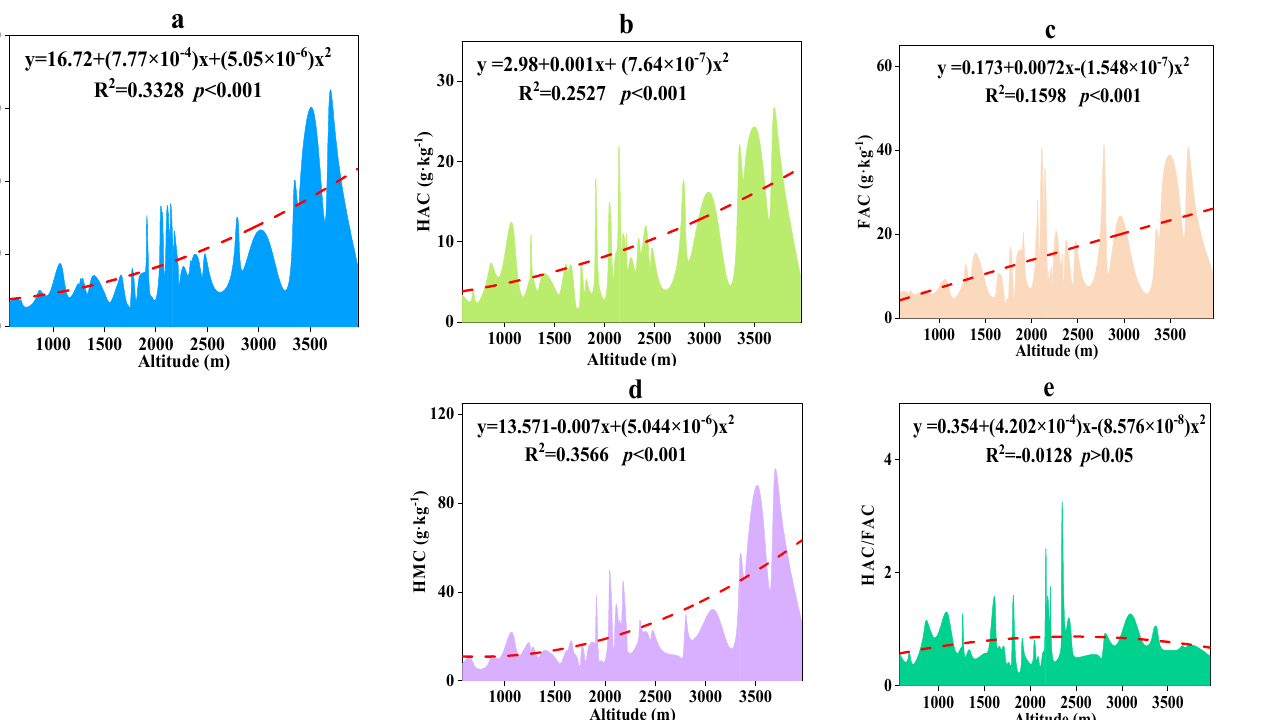
Figure 6. Relationship between altitude and the composition of soil organic matter (figure ( a ): SOC; figure ( b ): HAC; figure ( c ): FAC; figure ( d ): HMC; figure ( e ): HAC/FAC). FAC, fulvic acid carbon; HAC/FAC, humic acid carbon/fulvic acid carbon; HAC, humic acid carbon; HMC, humin carbon; SOC, soil organic carbon.